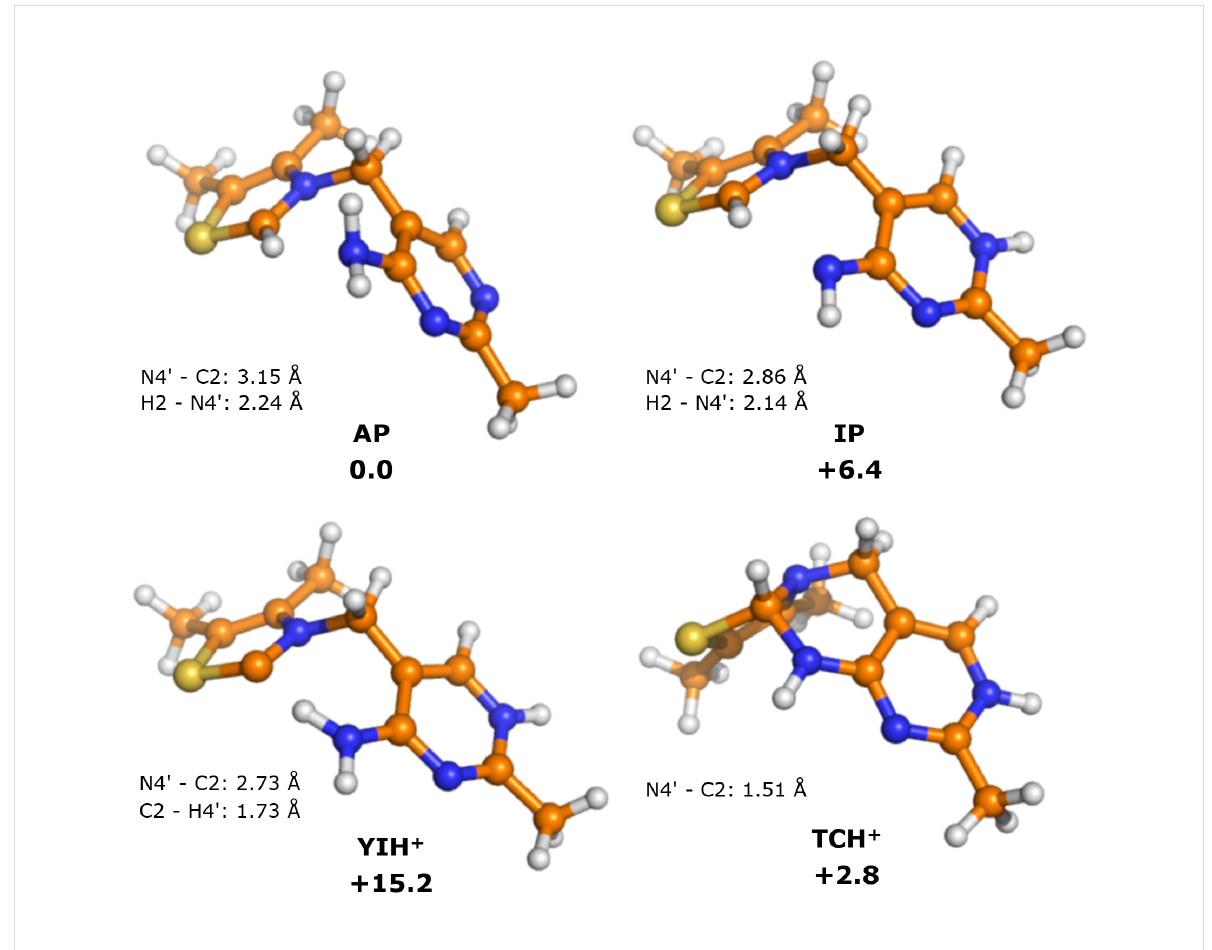
Figure 2: Optimized structures of the states of ThDP in the absence of enzyme (model A ). Relative energies are indicated in kcal/mol.